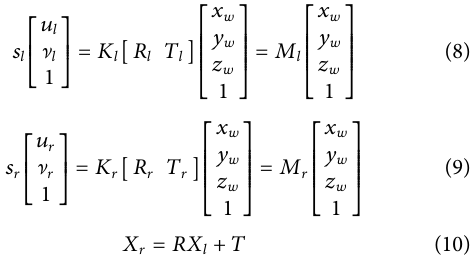
cameras. X r and X l are the 3D coordinates of the point P of the left and right cameras. Thus, the R and T from the left camera system to the right camera coordinate system could be calculated. Figure 7. Therein, the automatic 3D measurement sensor consists